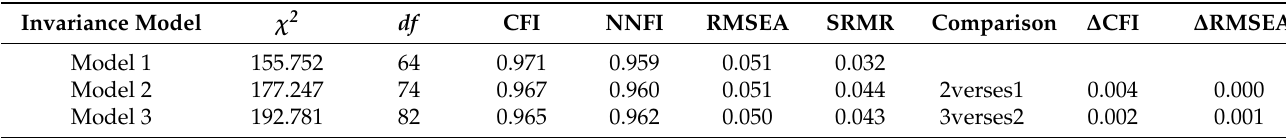
Table 1. Measurement invariance across